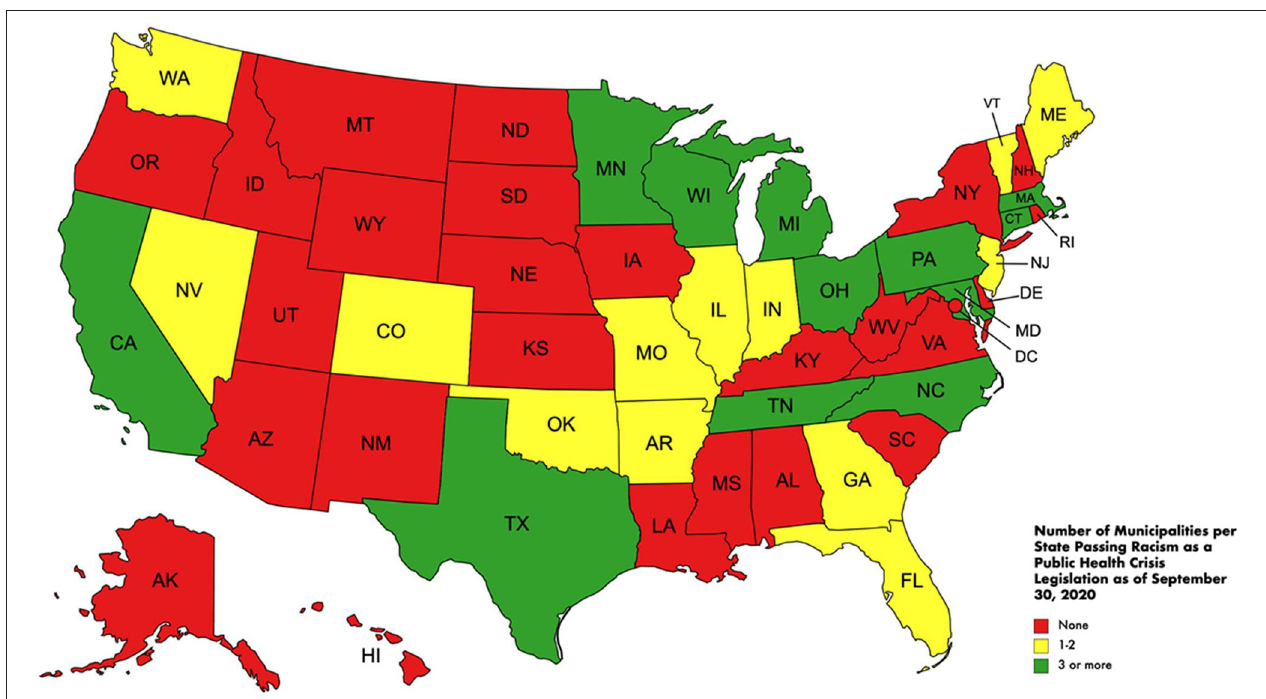
FIGURE 1 | Geographical distribution of racism as a Public Health Crisis legislation through September 30,